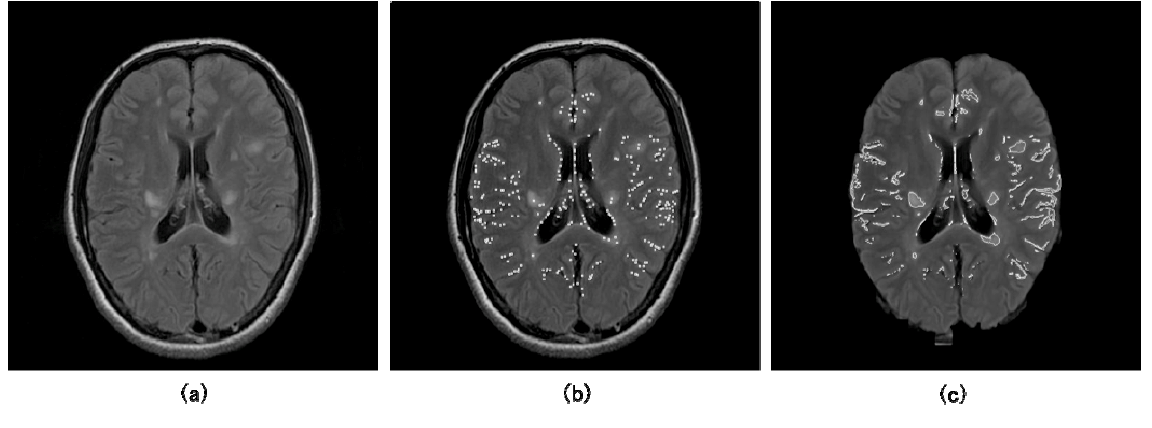
Figure 6. Illustrations of (a) an original FLAIR image, (b) initial MS candidate points (white dots) obtained by the multiple gray level thresholding technique, and (c) initial candidate regions (white solid lines) segmented by the region growing technique